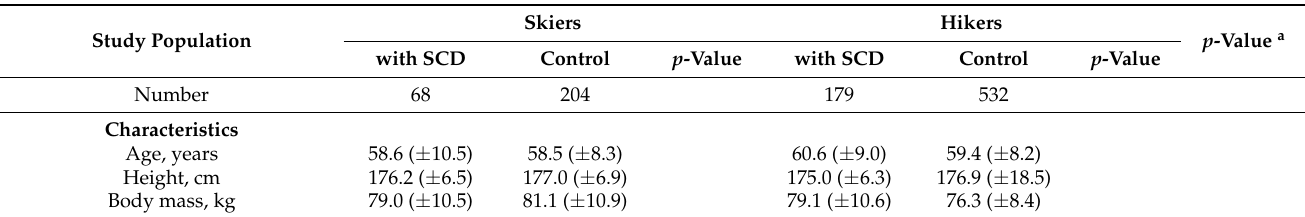
Hikers p -Value a